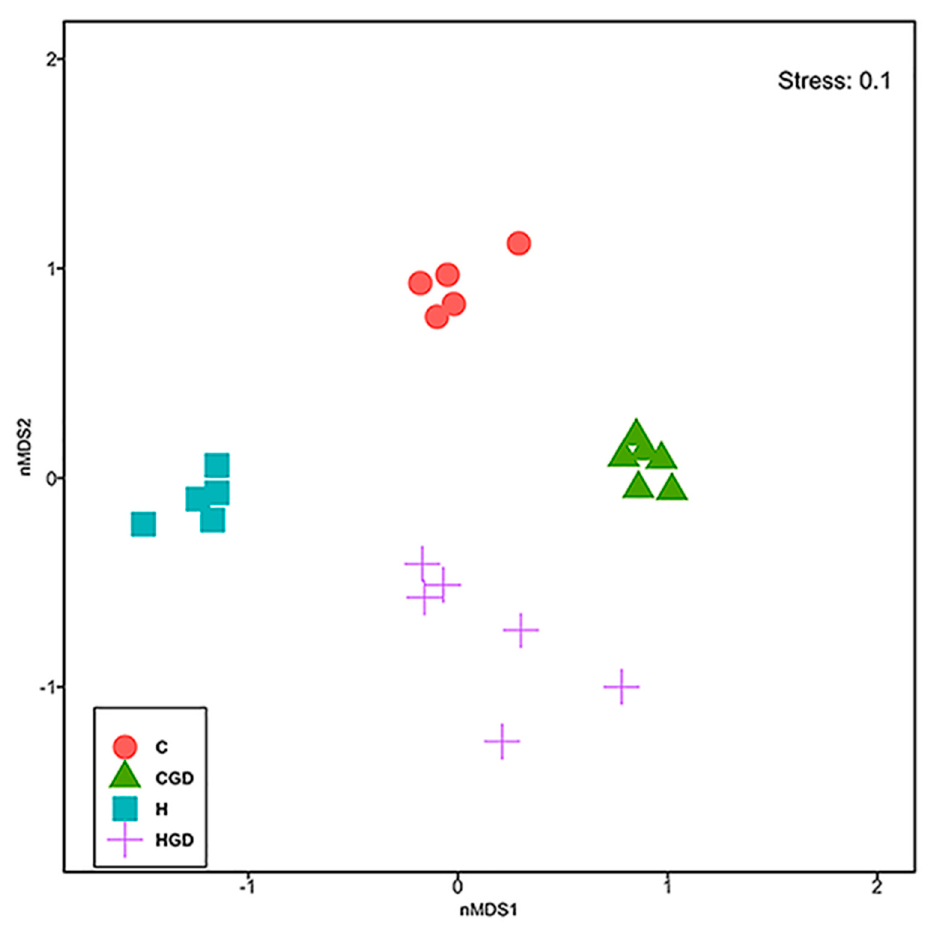
Figure 8. Non-metric, multi-dimensional scaling (nMDS) plot of bacterial community structure of faecal samples from C, CGD, H and HGD rats. C, corn starch diet-fed rats; CGD, corn starch diet-fed rats treated with Garcinia dulcis rind powder; H, high-carbohydrate, high-fat diet-fed rats; HGD, high-carbohydrate, high-fat diet-fed rats treated with Garcinia dulcis rind powder.